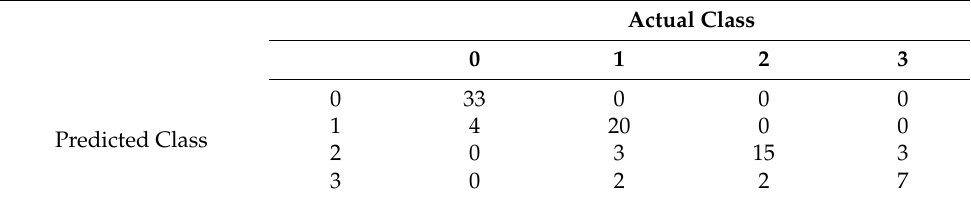
Table 9. Confusion matrix for the dual simplex algorithm execution time.